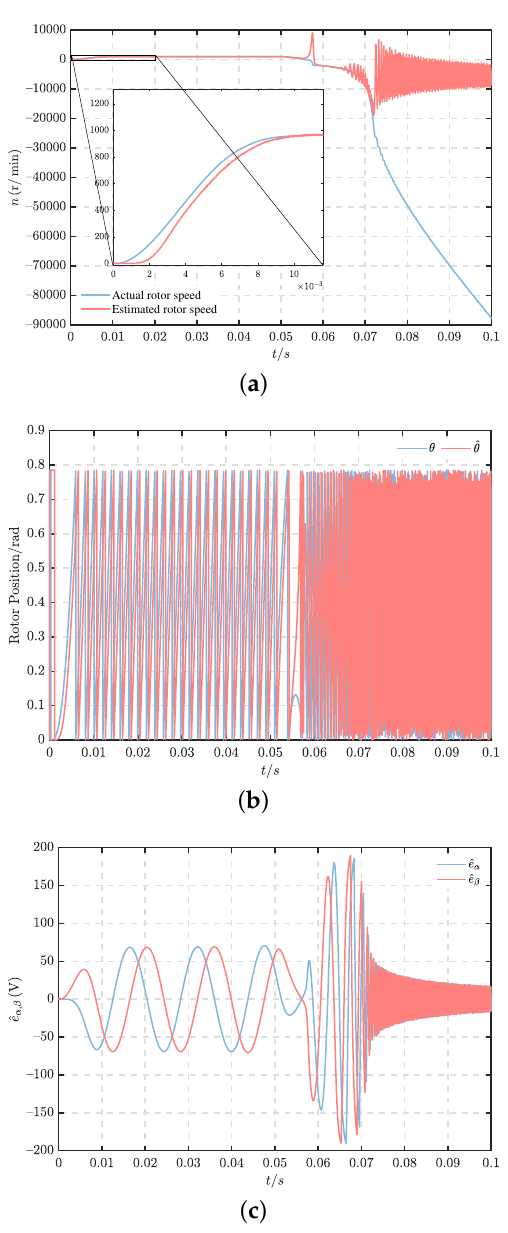
Figure 20. Responses of the simulation with conventional SMO combined with conventional PLL (with propeller load). ( a ) Rotor speed. ( b ) Rotor position. ( c ) Estimation of the